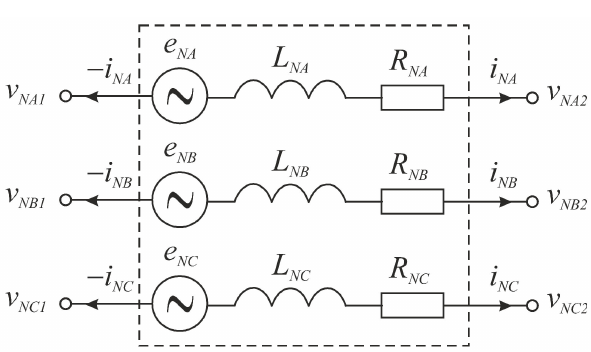
Figure 8. Calculation scheme of a three-phase network with a